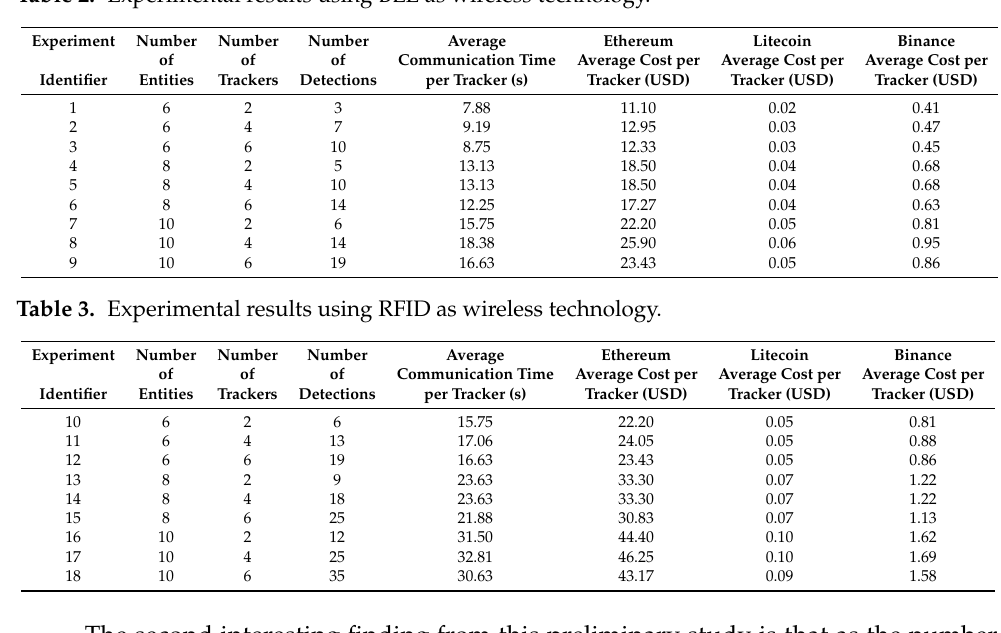
Table 2. Experimental results using BLE as wireless technology.